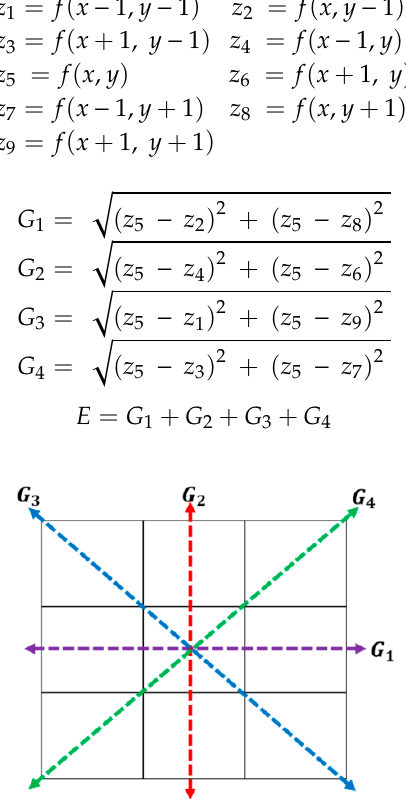
Figure 1. Gradients direction G i .